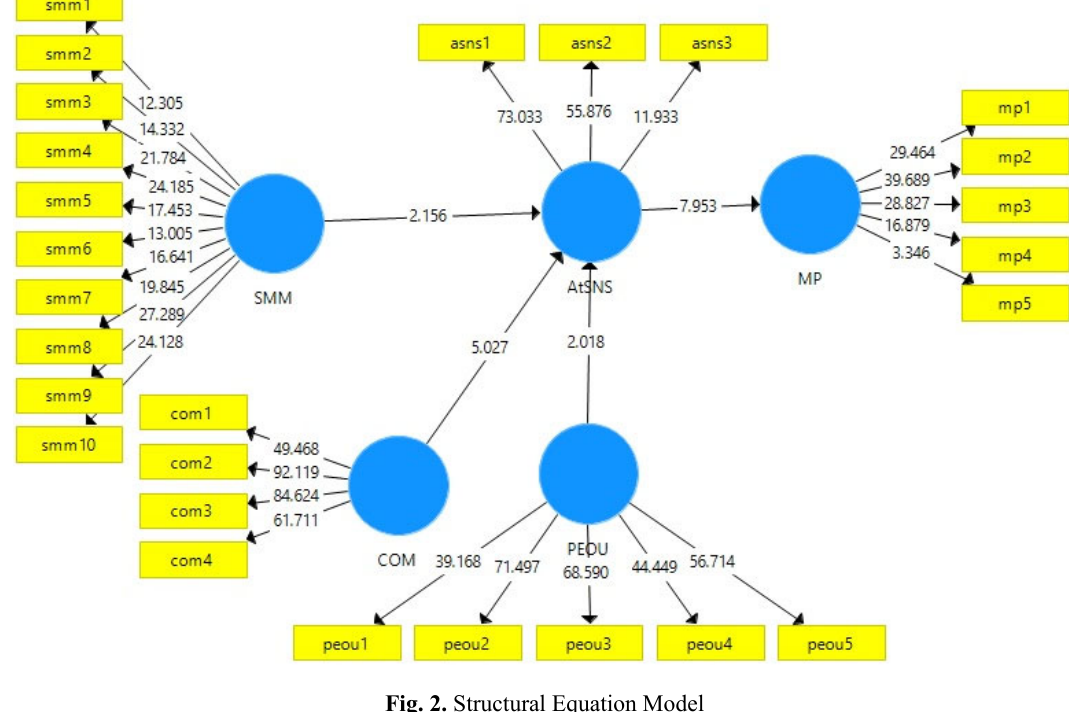
Fig. 2. Structural Equation Model